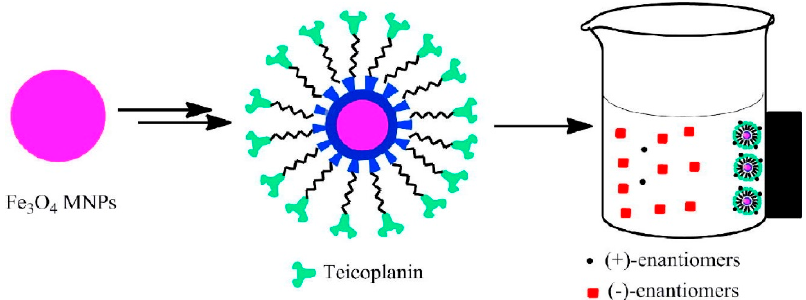
Figure 2. Magnetic separation of ( + )-Trp and ( + )-Phe by means of teicoplanin-functionalized MNPs. Reprinted with permission from [29], Copyright Elsevier.